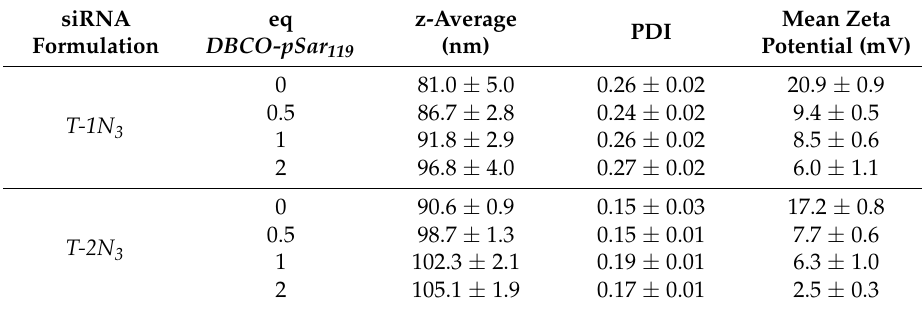
Table 1. Particle size (z-average) and zeta potential of pSar-shielded siRNA formulations determined by a dynamic light scattering (DLS) zetasizer. siRNA polyplexes were prepared at N / P 12. siRNA